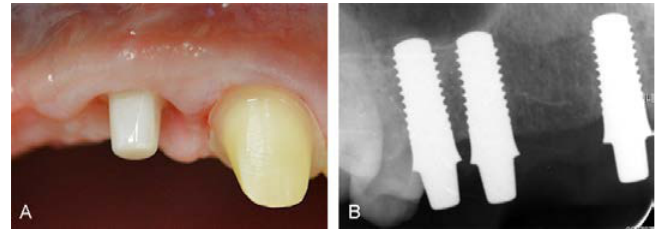
Figure 8. ( A ) Completely non-irritated peri-implant soft tissues of implant in region of 11 just prior to cementation of definitive prosthesis. ( B ) Radiographic investigation at nine months after implant placement, just prior to definitive